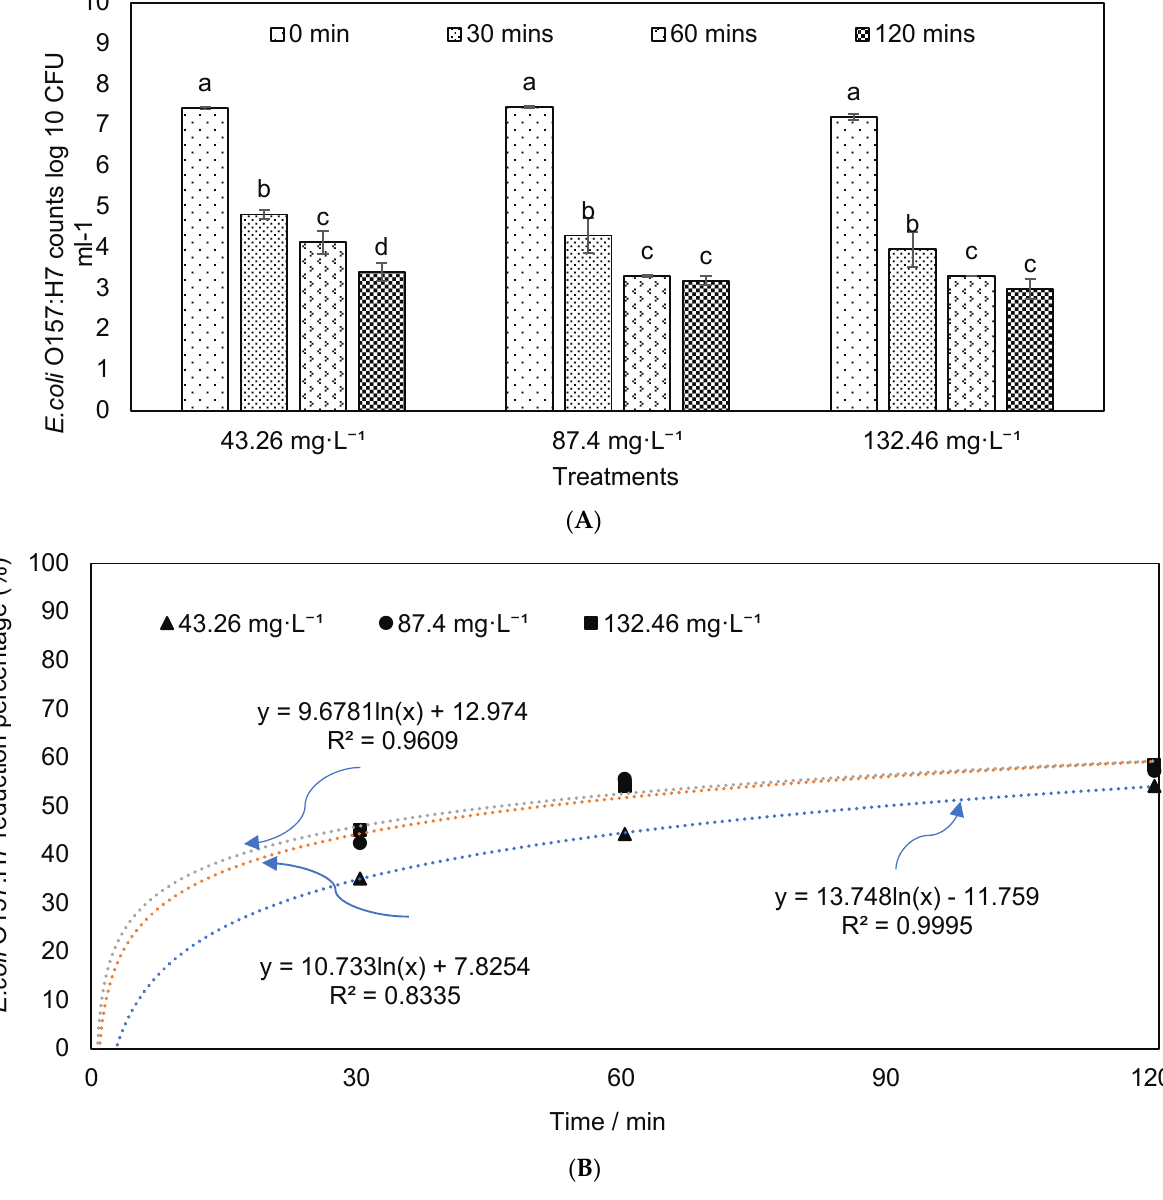
Figure 3. Change in E. coli levels in autoclaved manure. ( A ) E. coli O157:H7 counts; ( B ) reduction percentages in the autoclaved dairy manure inoculated with E. coli O157:H7 under different ozone concentrations and durations (means denoted by a different letter indicate significant differences between treatments ( p < 0.05)).